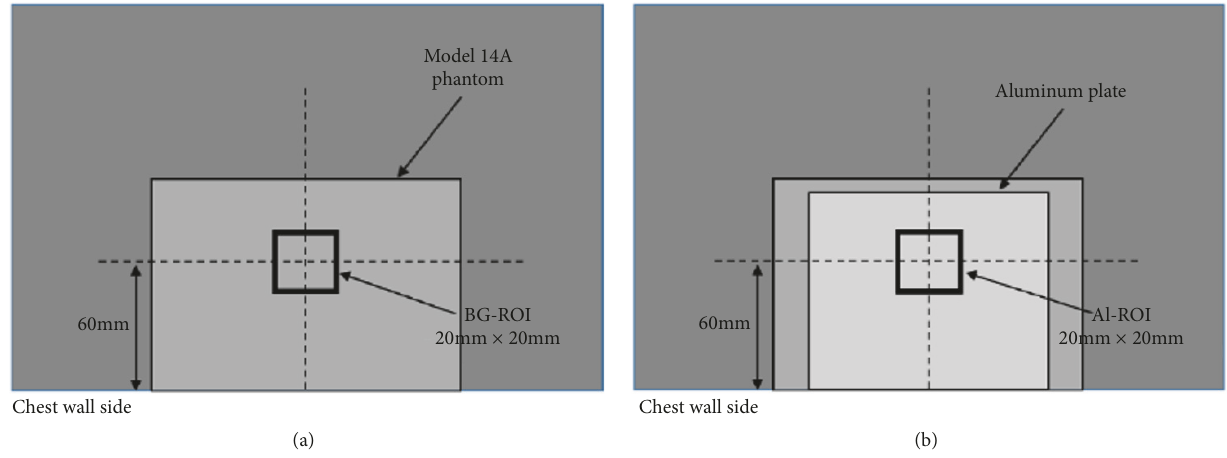
Figure 2: Schematic showing the region of interest (ROI) in the breast-equivalent phantom (a) without and (b) with the aluminum plate. Pixel values were calculated using ImageJ in the ROI without (BG-ROI) and with (Al-ROI) the aluminum plate.